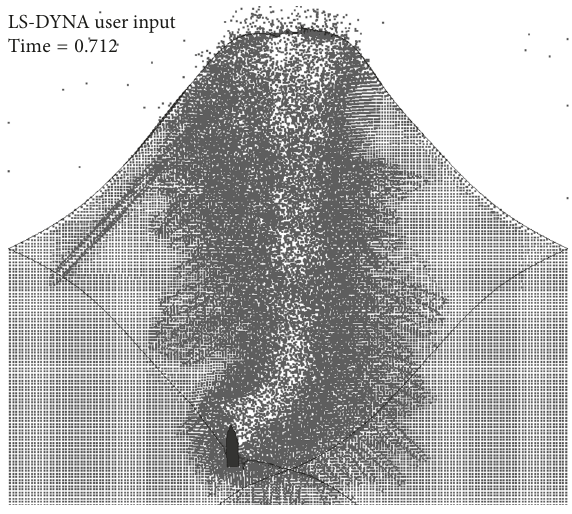
Figure 17: Energy transfer during the penetration.